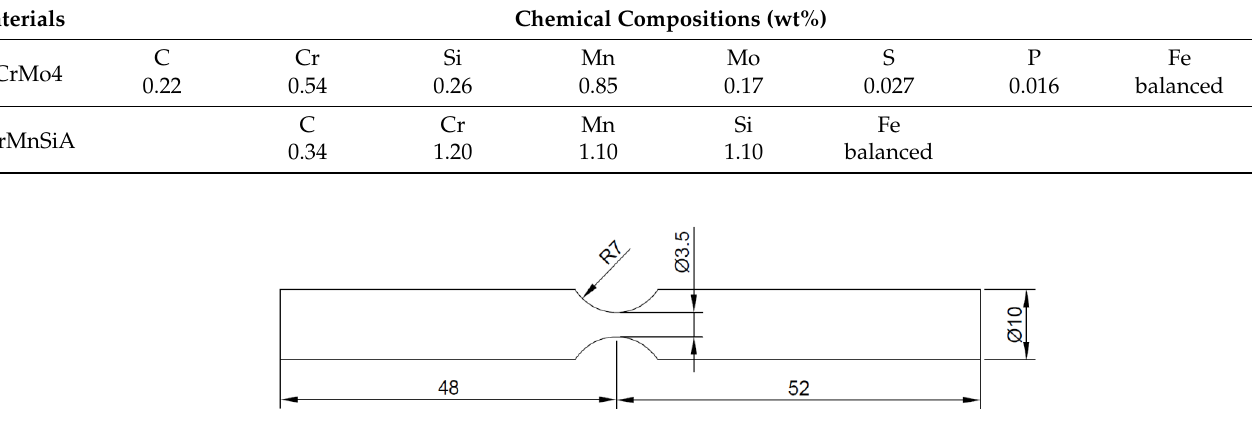
Table 1. Chemical compositions of the tested steels.